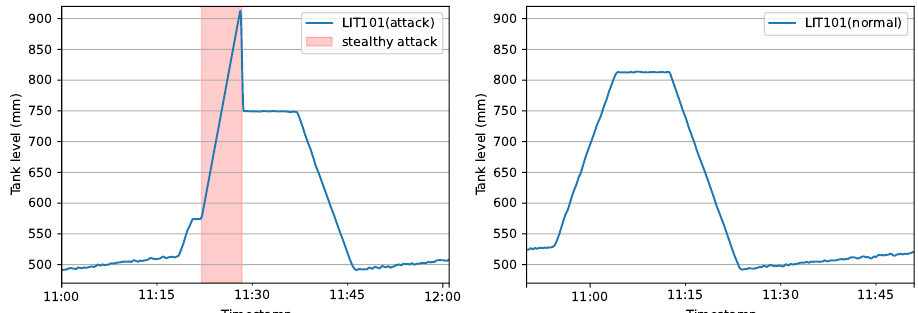
Figure 8. Stealthy attack ( left ) on the level sensor LIT101 in P1 of the SWaT testbed. Normal operation of a working cycle is illustrated in the right panel for comparison.